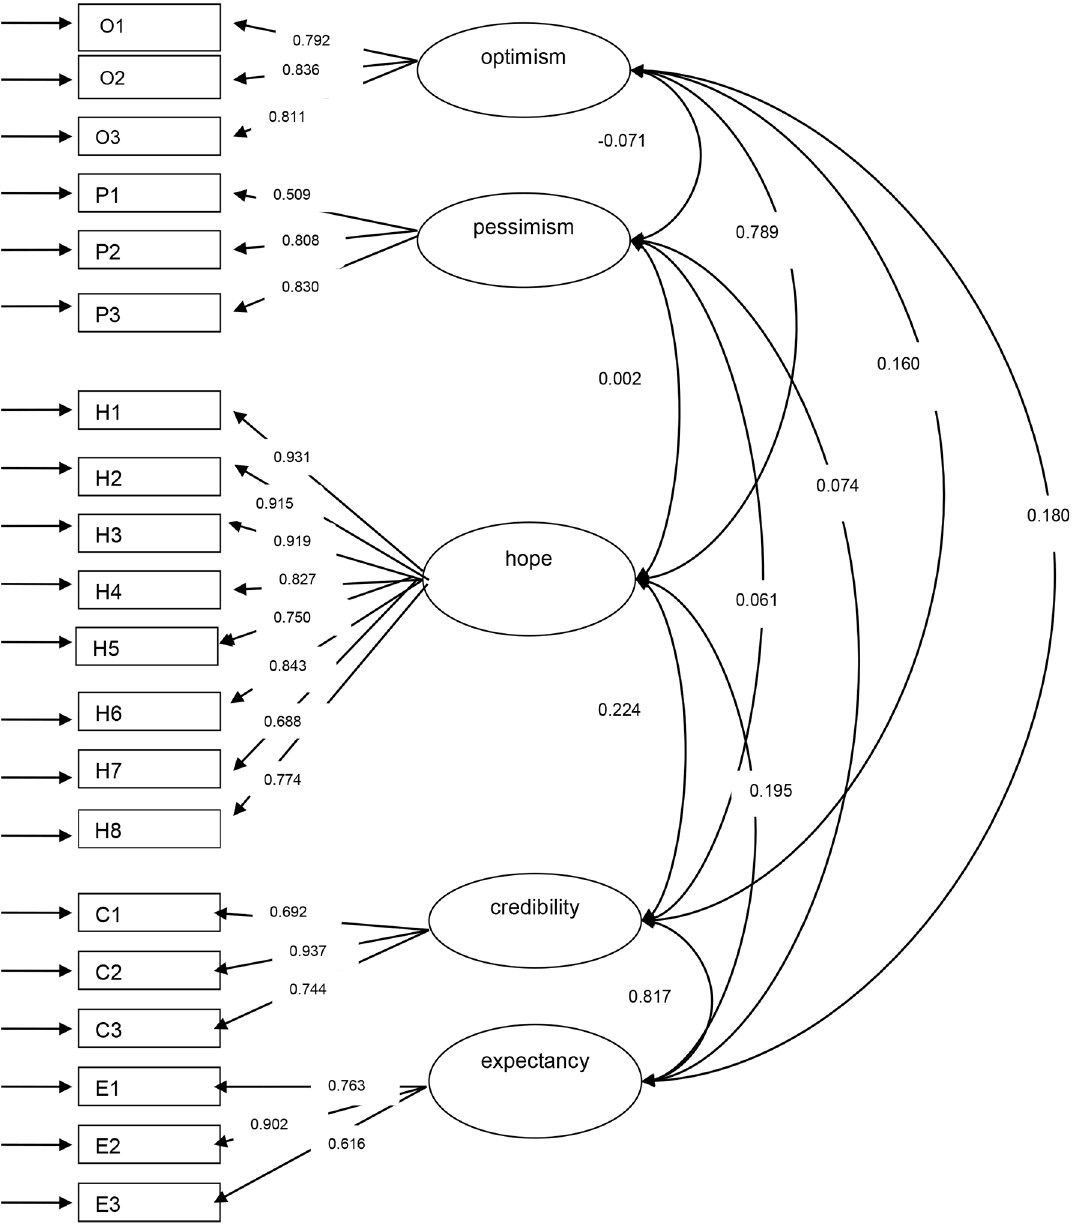
Fig 1. Path diagram and standardized factor loadings and correlations between factors for the 5 factor model. O1 — O3 = LOT-R optimism items 1 to 3,P1 — P3 = LOT-R reverse scored pessimism items 1 to 3,H1 — H8 = ADHS hope items 1 to 8,C1 — C3 = CEQ credibility items 1 to 3,E1 — E3 = CEQ expectancy items 1 to 3 ovals represent latent factors, squares represent observed variables, factor loadings are represented by the arrows between ovals and squares and correlations between factors are represented by the arrows between the ovals.